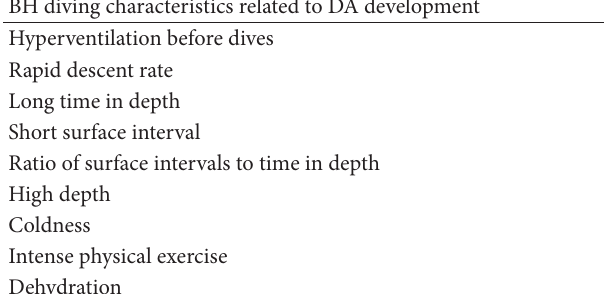
Table 1: Several diving characteristics could be involved in the pathophysiology of DA during BH dives. Short surface intervals, high depth, and number and frequency of repeated dives appear to increasetheriskofDA.Otherelementsasexcessivehyperventilation before dives, intense physical exercise, and physiologic responses to the underwater environment could be considered as promoting fac-